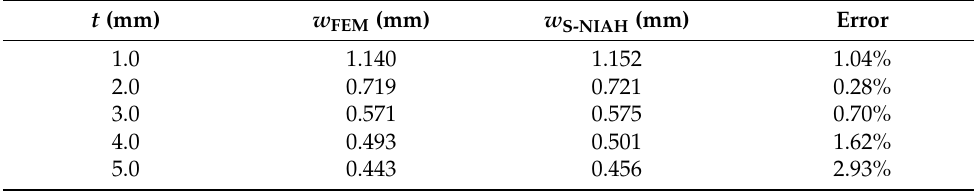
Table 3. Deflections and errors at centre of plate versus t .